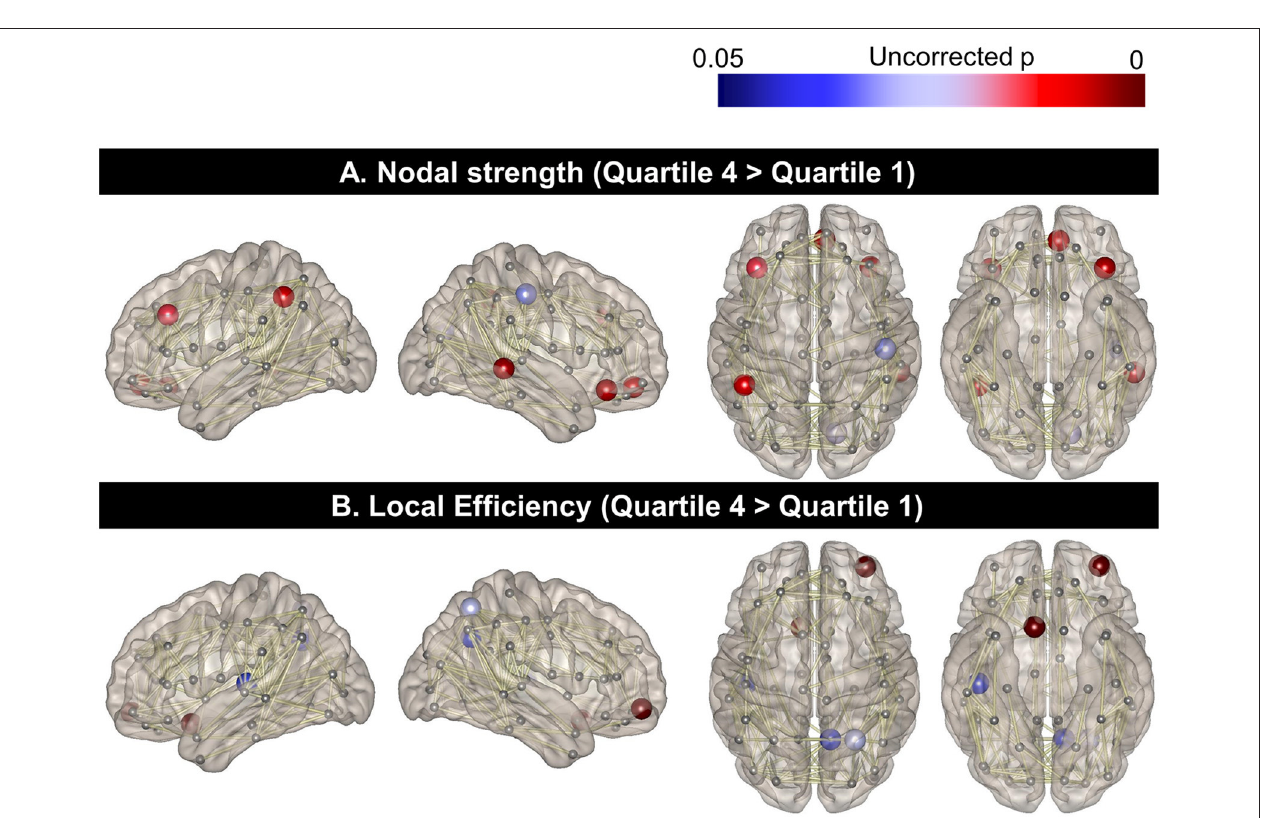
FIGURE 1 | Topographical differences in regional nodal strength and local efficiency between the two extreme PA quartiles. Regional nodal strength in the left middle frontal cortex, orbitofrontal cortex, and inferior parietal lobules as well as the right middle temporal and orbitofrontal gyrus for Quartile 4 was greater than that of Quartile 1 (A) . The local efficiency of the left rectus gyrus and the right superior parietal, precuneus, and orbitofrontal cortices was also higher in Quartile 4, compared to the Quartile 1 group (B)